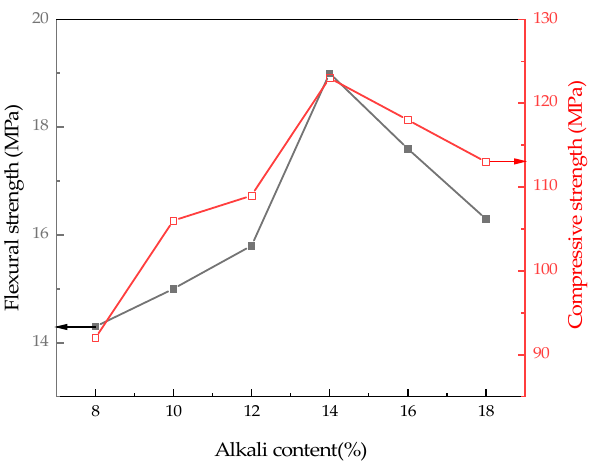
Figure 7. Mechanical strengths of alkali-activated BFS with different alkali contents.